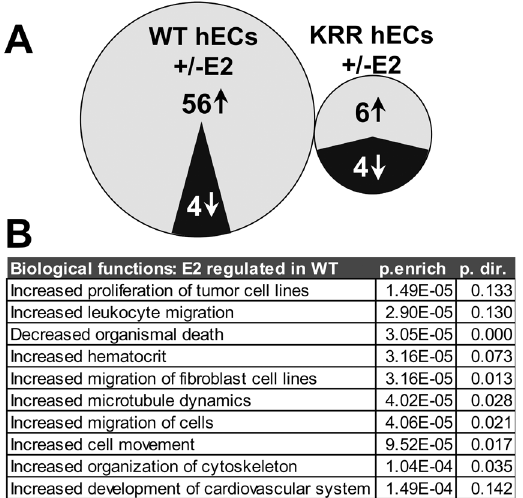
Fig 4. Most E2/ER α -regulated genes in hECs require rapid signaling, and rapid signaling-dependent genes are associated with increased cell migration and proliferation. (A) Venn diagrams depicting the number of genes upregulated or downregulated by 16 hr treatment with 10nM E2 in WT_hECs or in KRR_hECs, and the lack of overlap between these gene sets. (B) Biological functions associated with genes regulated by E2 in WT but not KRR hECs. “ p. enrich ” and “ p. dir ” are the p. values for enrichment of WT hEC E2-regulated genes with genes associated with that function, and for the predicted direction of effect,